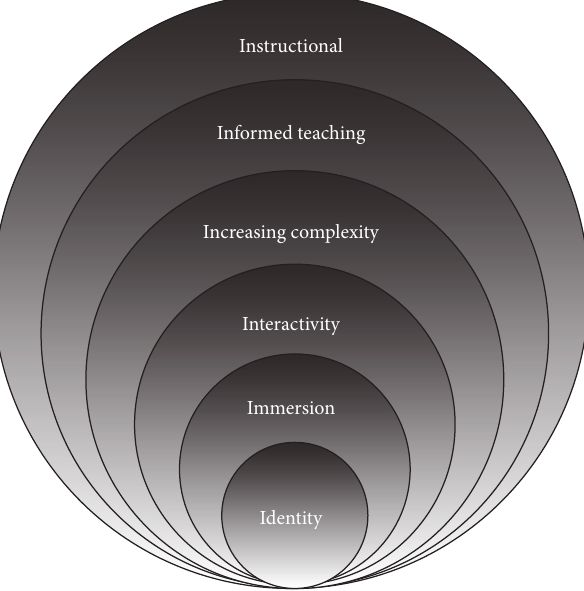
Figure 2: Nested elements for educational game.